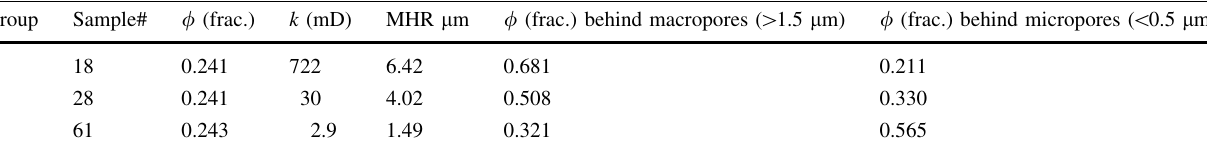
Table 4 A comparison of petrophysical and capillary pressure properties of the representative samples belongs to the three groups